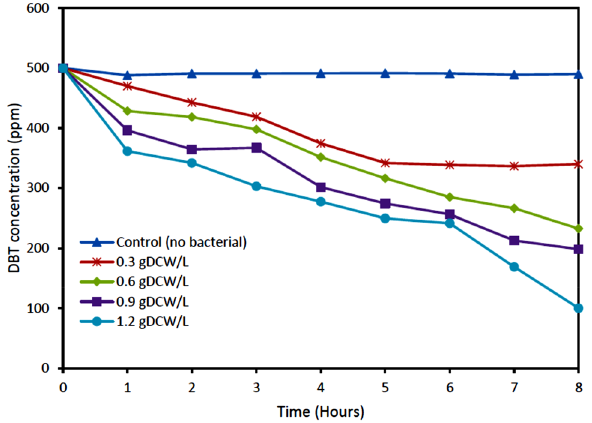
Figure 3. Effect of cell concentrations of Pseudomonas putida during degradation of DBT. Experimental conditions: Initial DBT concentrations 500 ppm, Temperature 30 °C, Shaking speed 130